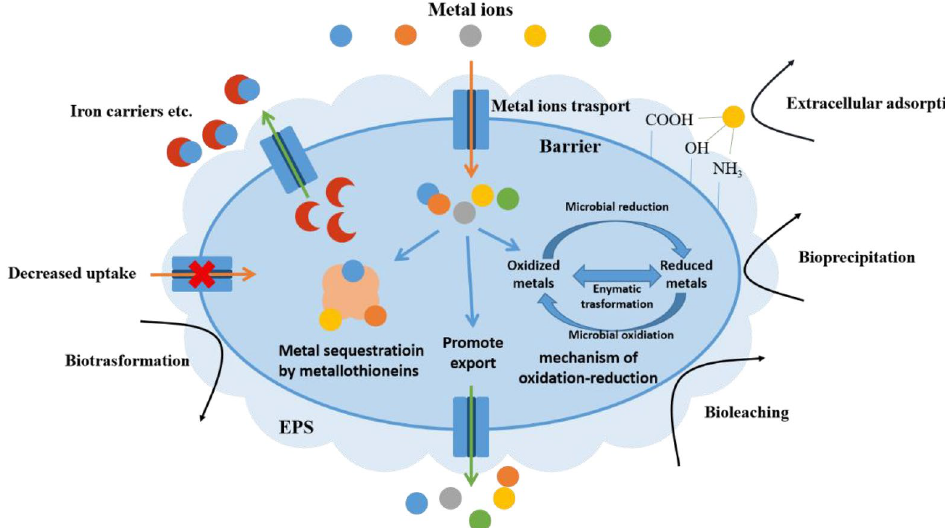
Fig. 5 Various detoxification mechanisms for microorganisms under